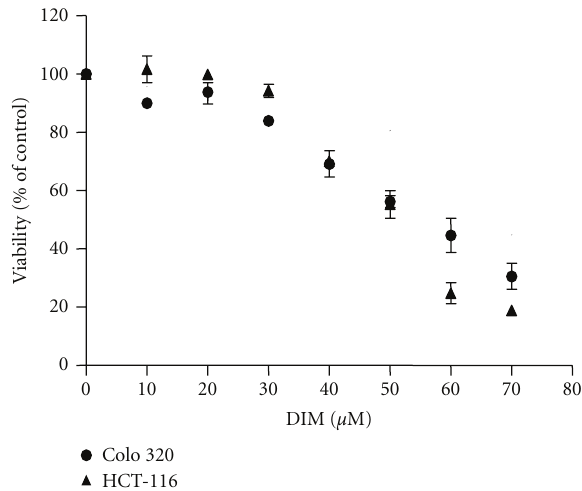
Figure 1: E ff ect of DIM on cell viability. Exponentially growing cells were incubated in the presence of 10 to 100 μ M of DIM for 72 hours, and the viable cells were detected by XTT assay. The results are presented as percentage of control and expressed as means ± SD of three independent